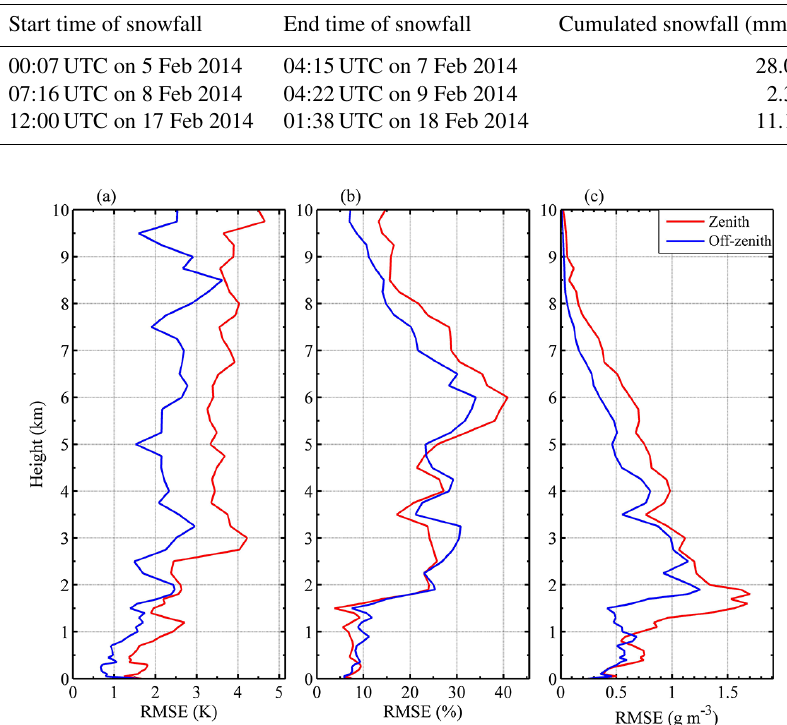
Figure 1. The comparison between zenith and off-zenith observations in non-precipitation conditions.